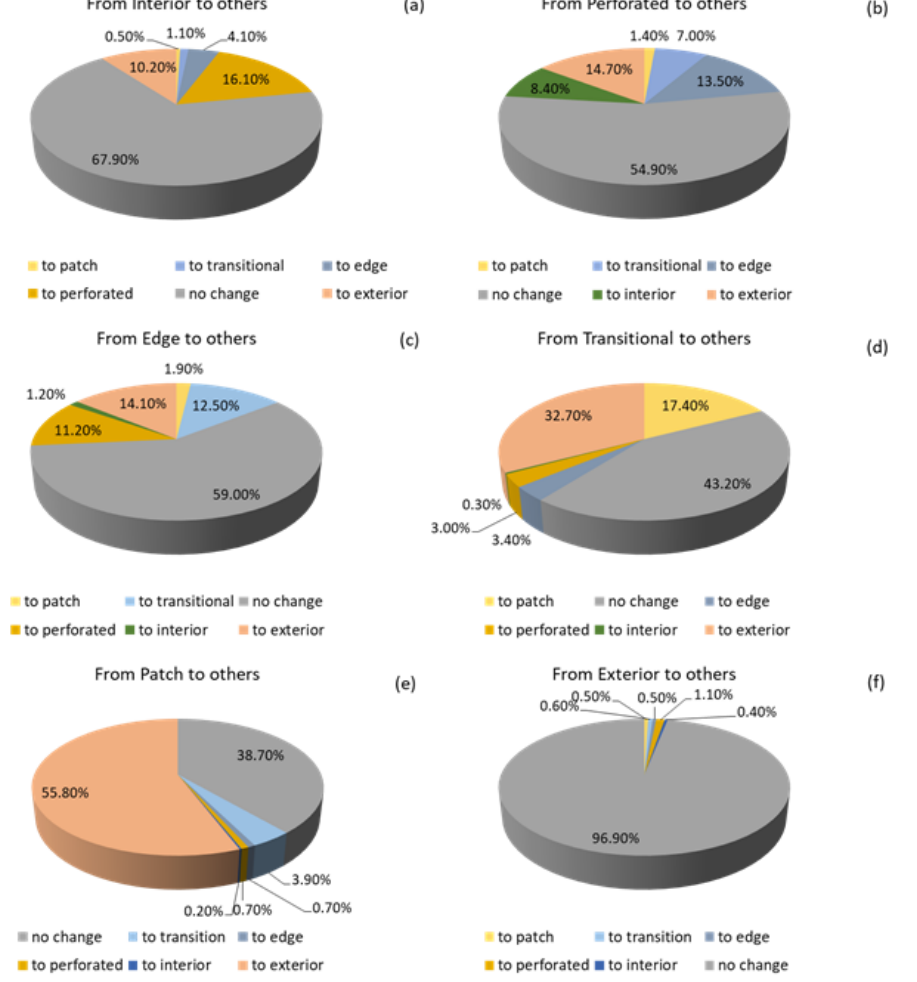
Figure 5. Changes between fragmentation categories during 2008–2018: ( a ) from interior to others, ( b ) from perforated to others, ( c ) from edge to others, ( d ) from transitional to others, ( e ) from patch to others, and ( f ) from exterior to others.